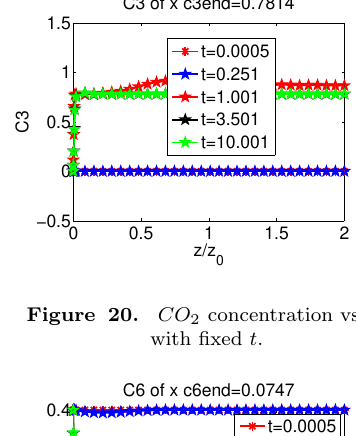
Figure 20. CO 2 concentration vs. x with fixed t .